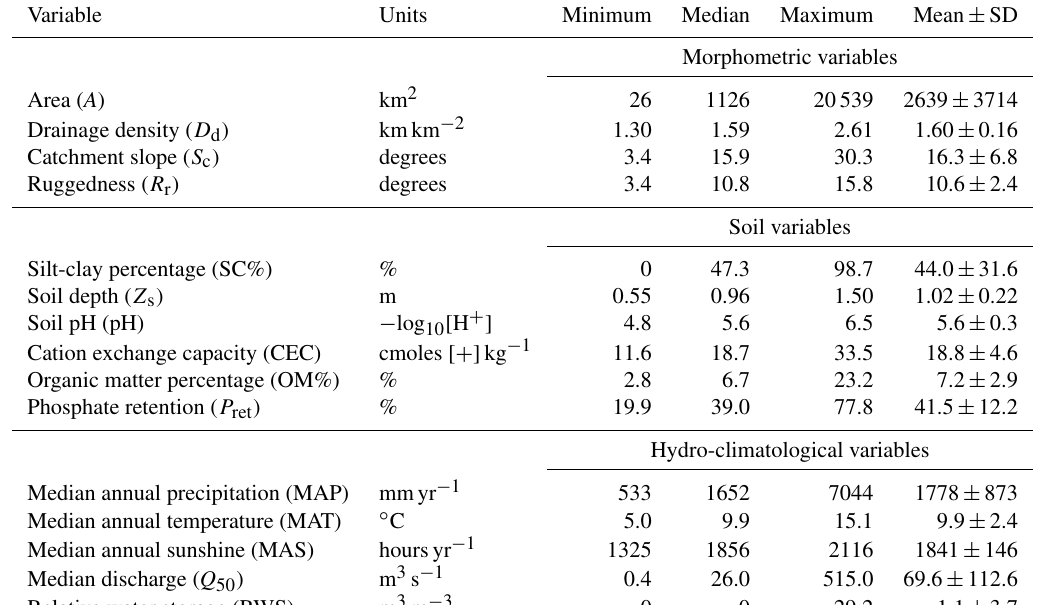
Table 4. Statistical description of landscape variables for the 77 NRWQN catchments. Refer to Tables 2 and 3 for variable descriptions.